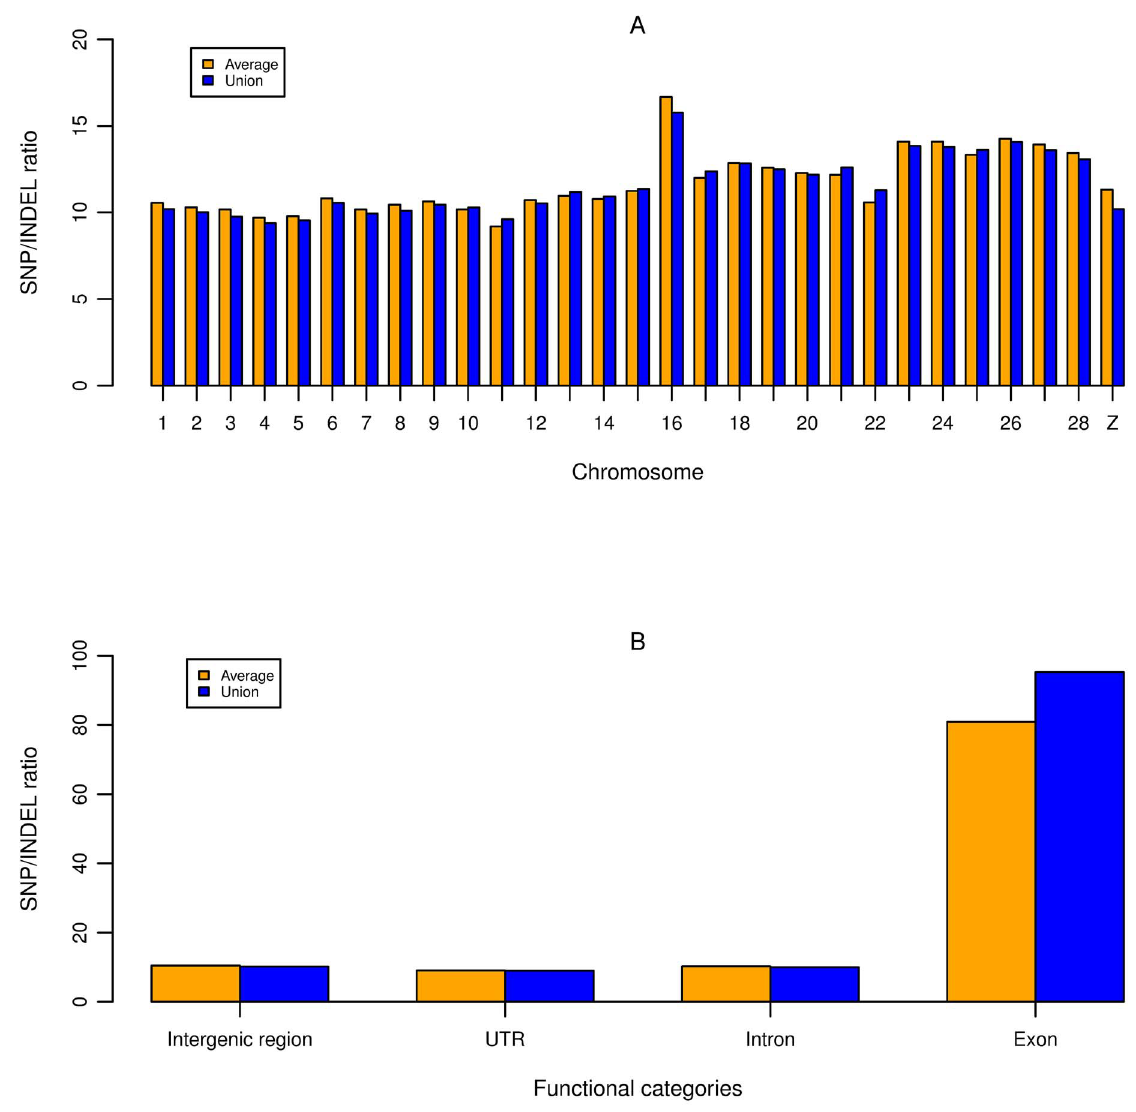
Figure 3. SNP to INDEL ratio. The ratios were plotted based on the non-redundant (Union) data and the data averaged by chickens (Average), respectively. A: SNP to INDEL ratio across chromosomes. B: SNP to INDEL ratios in functional categories.